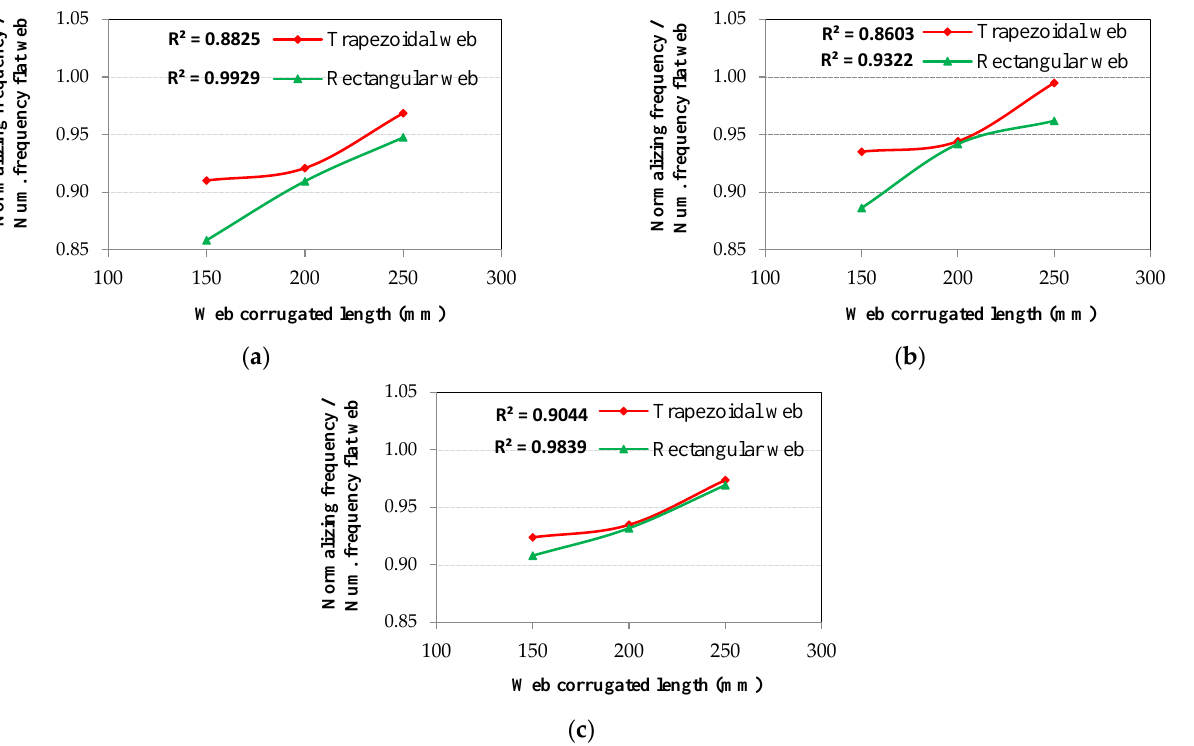
Figure 24. The relationship between normalized frequencies and corrugated web length: ( a ) frequency at the 1st mode shape, ( b ) frequency at the 2nd mode shape, and ( c ) frequency at the 3rd mode shape.